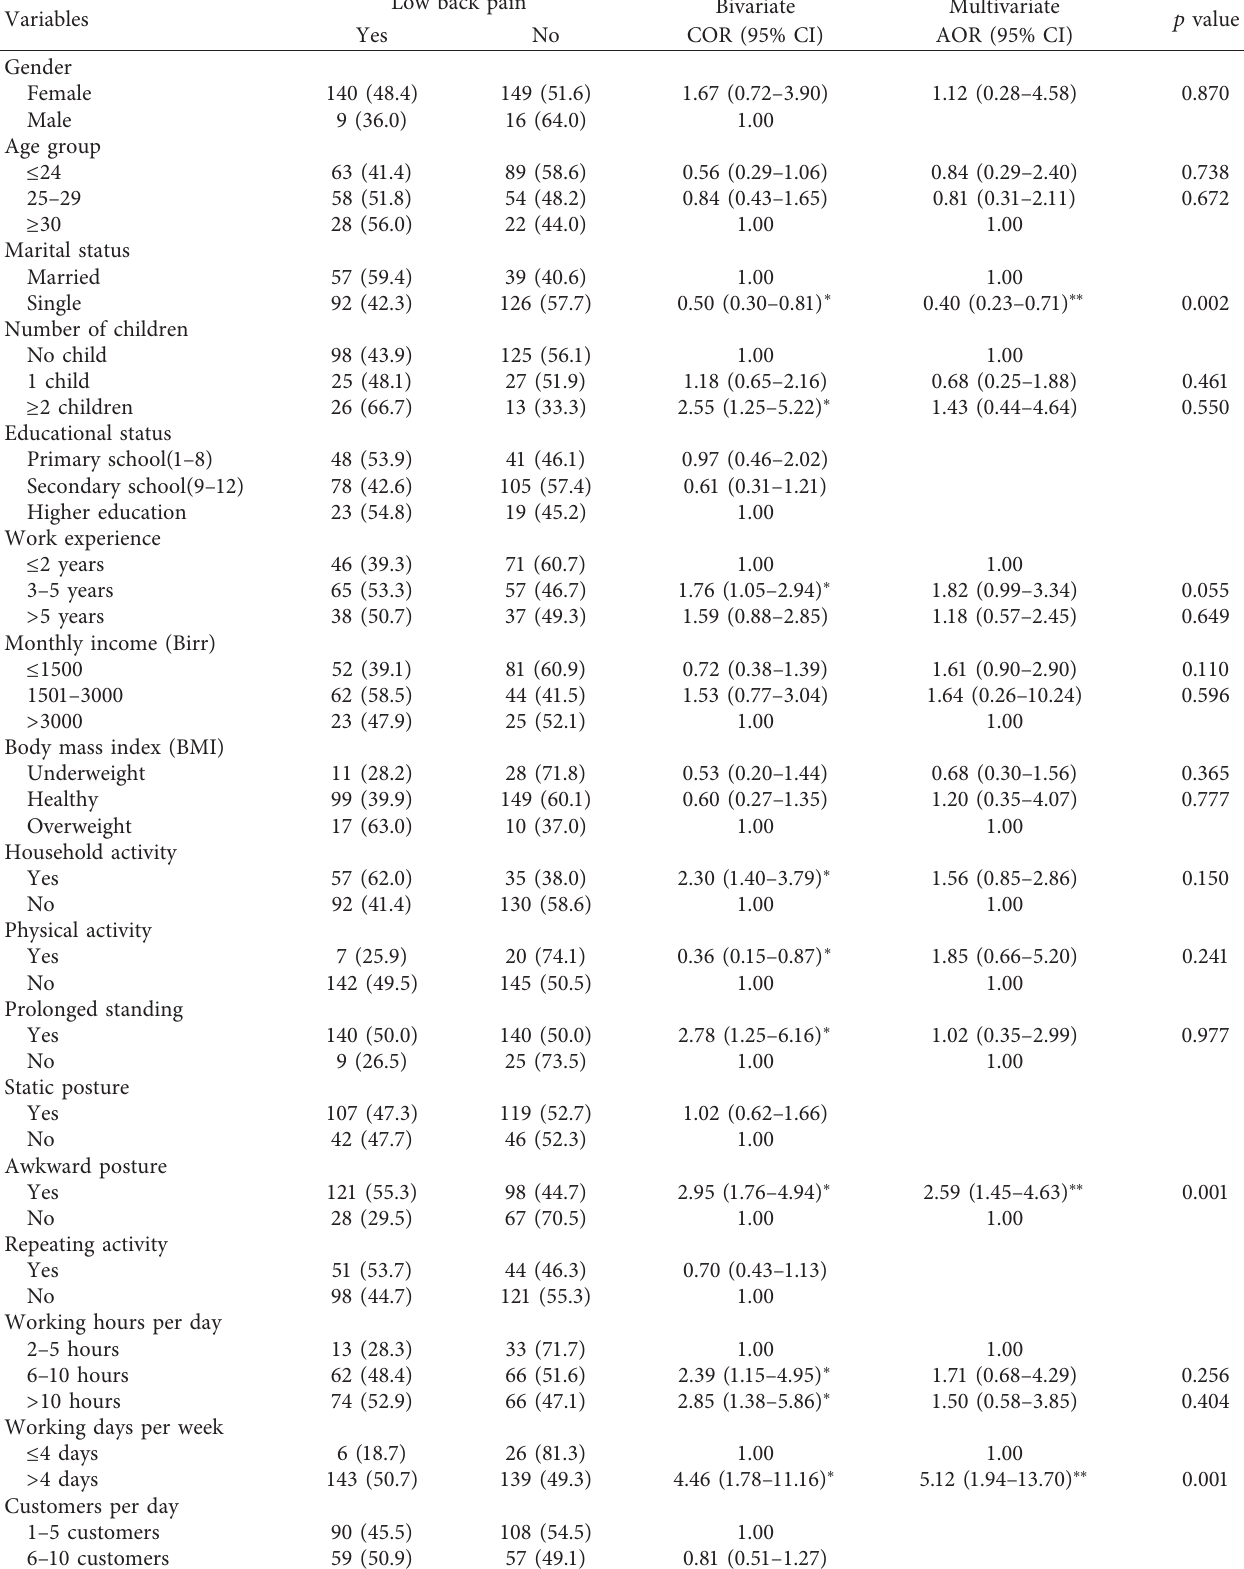
Table 4: Bivariate and multivariate logistic regression analysis of factors associated with LBP among the study participants, April 2018 ( n �